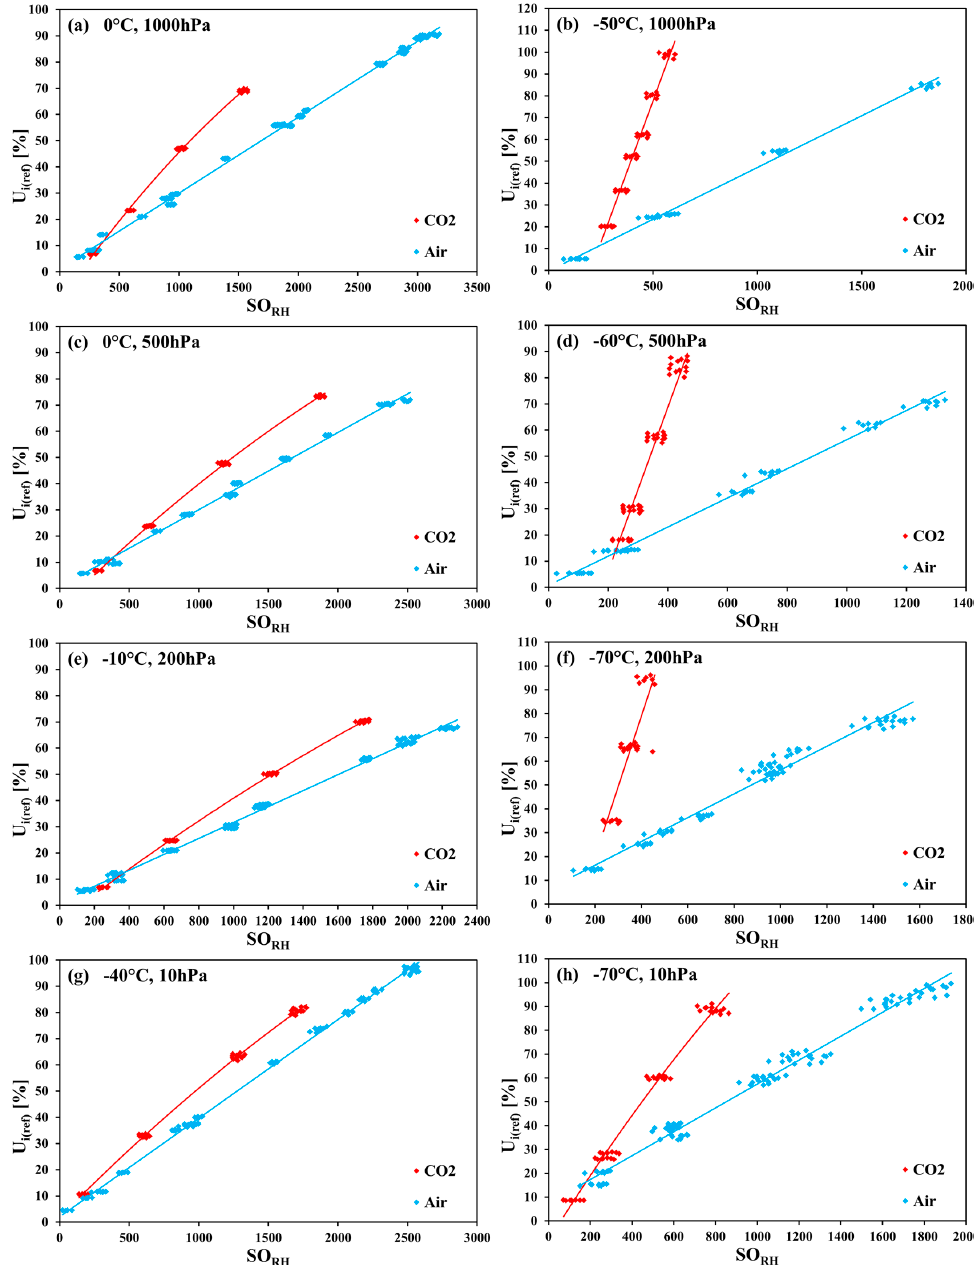
Figure 4. Exemplary collations of the SHT75 sensor characteristic curves (regression lines fitted to measurement points collected from all tested sensors) for the relative humidity measurement in CO 2 and in air, at selected temperature–pressure combinations.